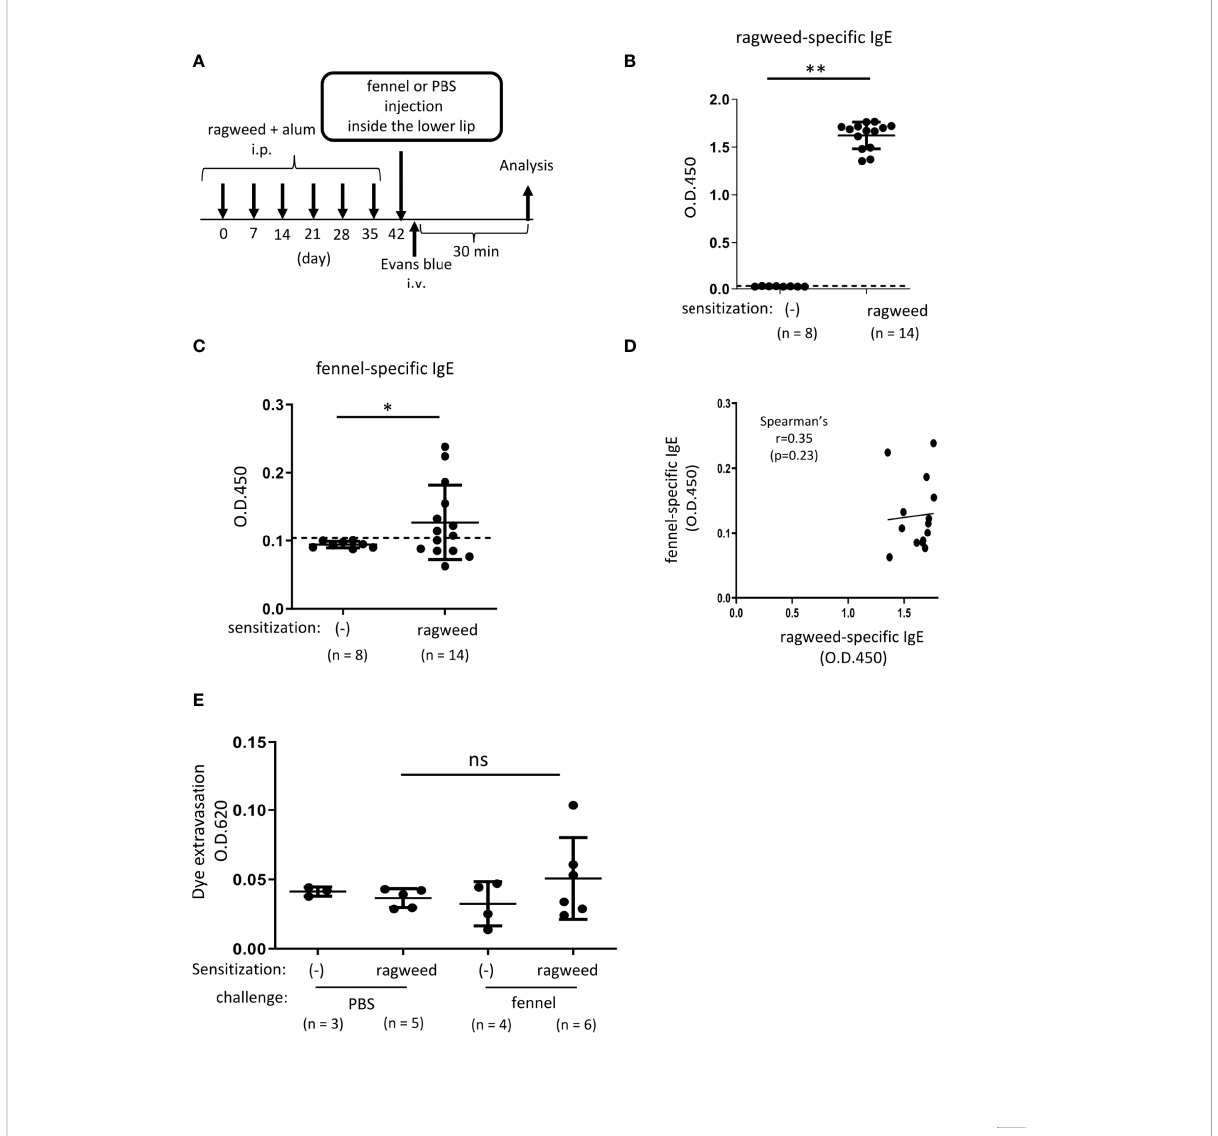
FIGURE 5 Stimulation with fennel extracts did not signi fi cantly induce OAS in mice intraperitoneally sensitized with ragweed pollen in murine model. (A) A schematic representation of murine model of OAS. WT mice intraperitoneally sensitized with ragweed pollen before stimulation with fennel or PBS as a control. (B-D) Serum levels of ragweed-speci fi c IgE (B) and fennel-speci fi c IgE (C) from mice intraperitoneally sensitized with ragweed pollen at day 42 (n = 14) or non-sensitized control mice (n = 8). (B, C) A positivity threshold (mean + 2SD in non-sensitized mice) is shown as a dotted line. Data are expressed as mean ± SD. Data are representative of two independent experiments. Welch ’ s t -test. ** P < 0.01. (D) No correlation between serum levels of ragweed-speci fi c IgE and fennel-speci fi c IgE from ragweed-sensitized mice (n = 14). Spearman ’